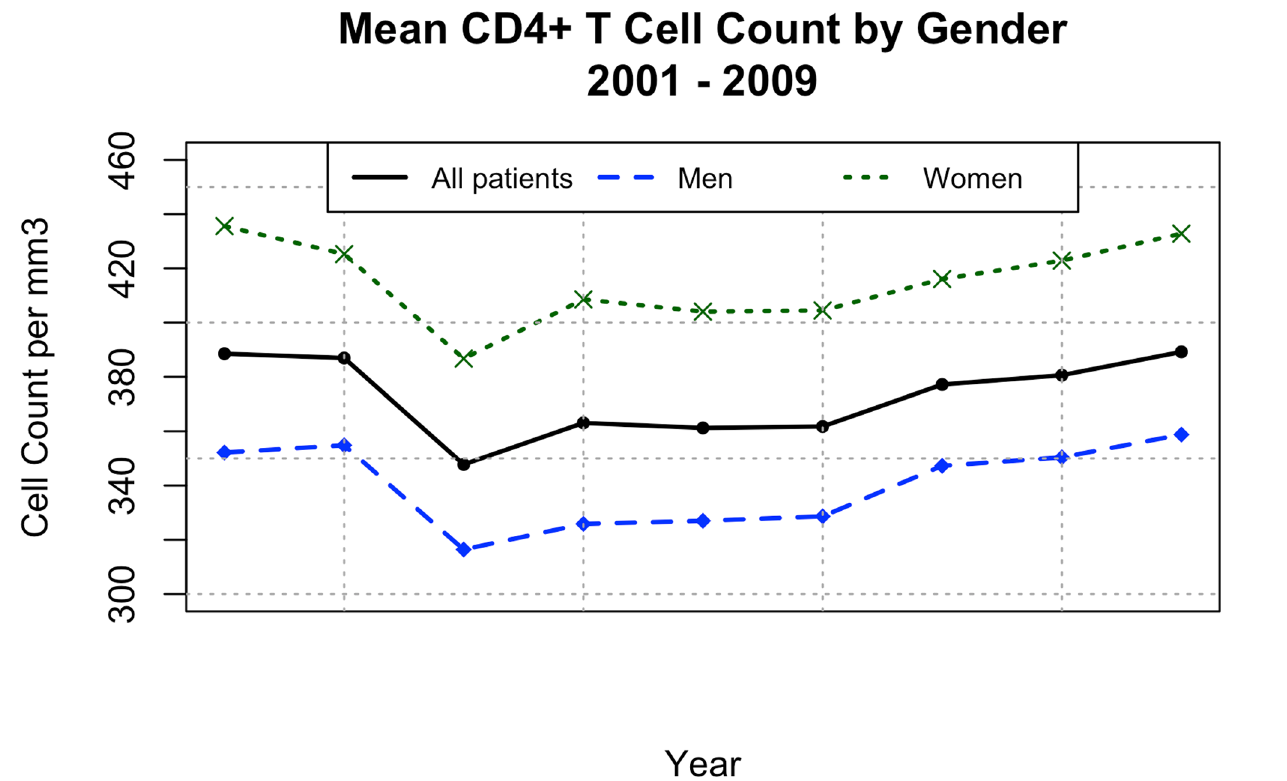
Fig 2. CD4 cell counts by gender. Mean CD4+ T cell counts by gender according to the first measurement for each patient from 2001 to 2009.